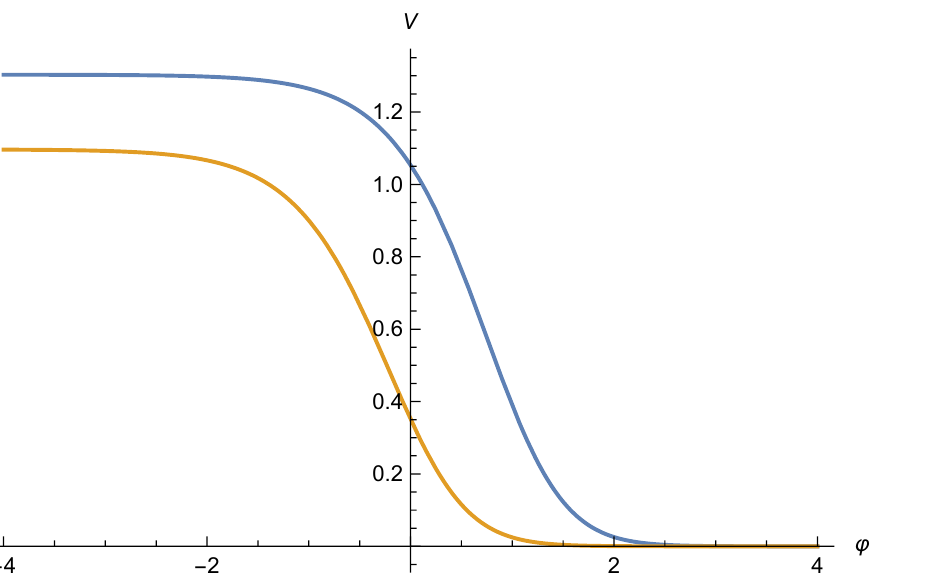
Figure 1. General shape of the scalar potential V ( ϕ ) for quintessential inflation. Both the scalar field ϕ and the potential V are in Planck units. The two curves correspond to models discussed